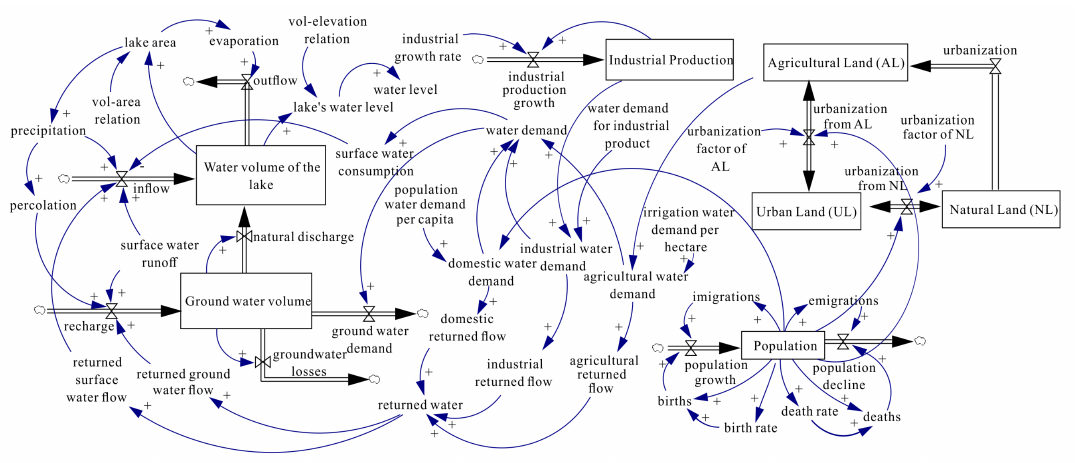
Figure 1. Stock-flow diagram for the Lake Issyk-Kul system dynamics (SD)